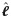
Evolution of ℓ^ on whitened natural image patches when using different training methods.GRBM-196-196s were trained on the whitened natural image data set using CD-1 and PCD-1 using different learning rates and momentum terms. The learning curves are the average over 10 trials. The gradient was restricted to one hundredth of the maximal data norm (0.48) and the learning rate for the variance parameter was set 100 times smaller than for the other parameters.